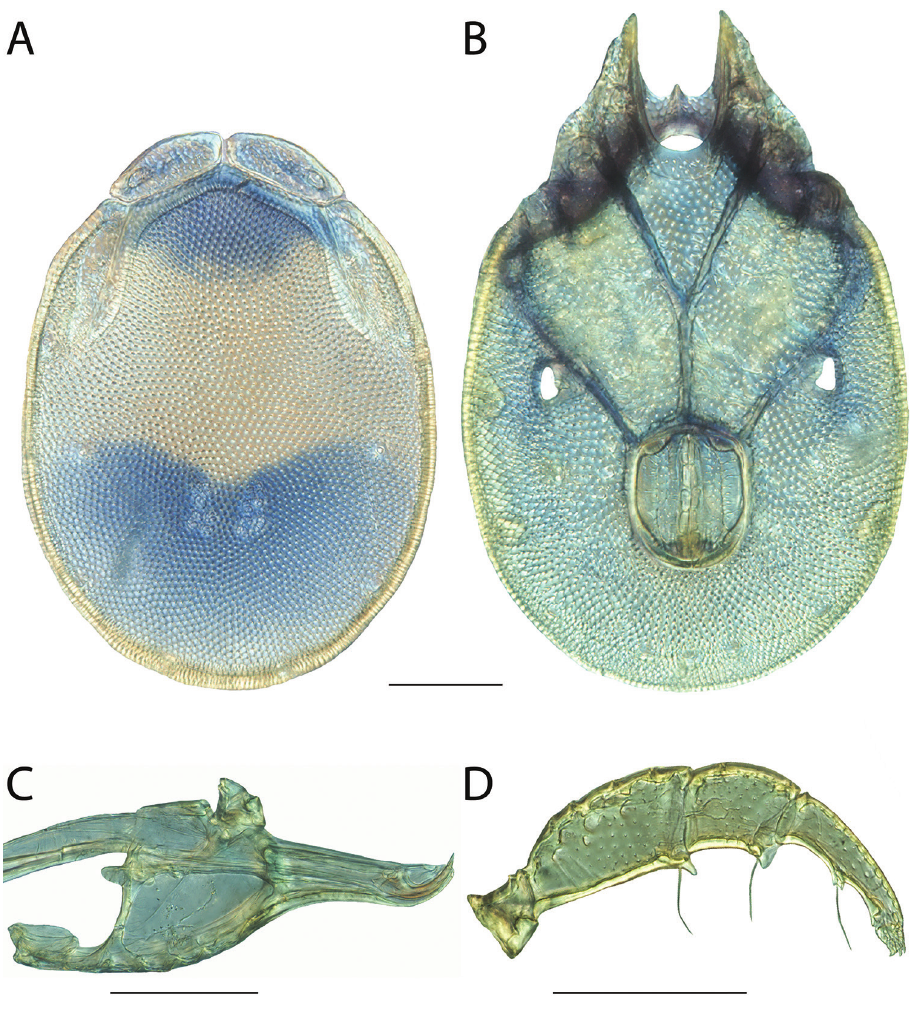
Figure 260. Torrenticola tysoni sp. n. male: A dorsal plates B venter (legs removed) C subcapitulum D pedipalp (setae not accurately depicted). Scale = 100